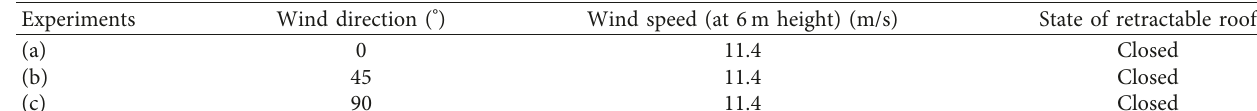
Table 7: Simulation conditions.